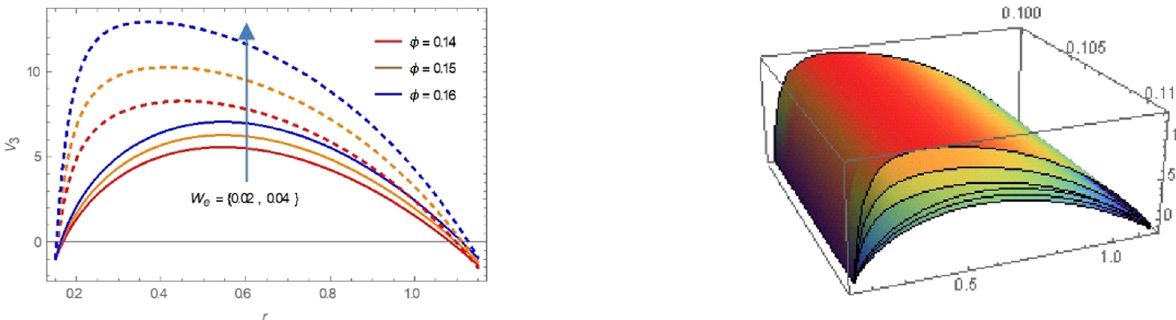
Figure 2: Distribution of velocity for di ff erent values of W e and ∅ with ϵ 0. 15 =